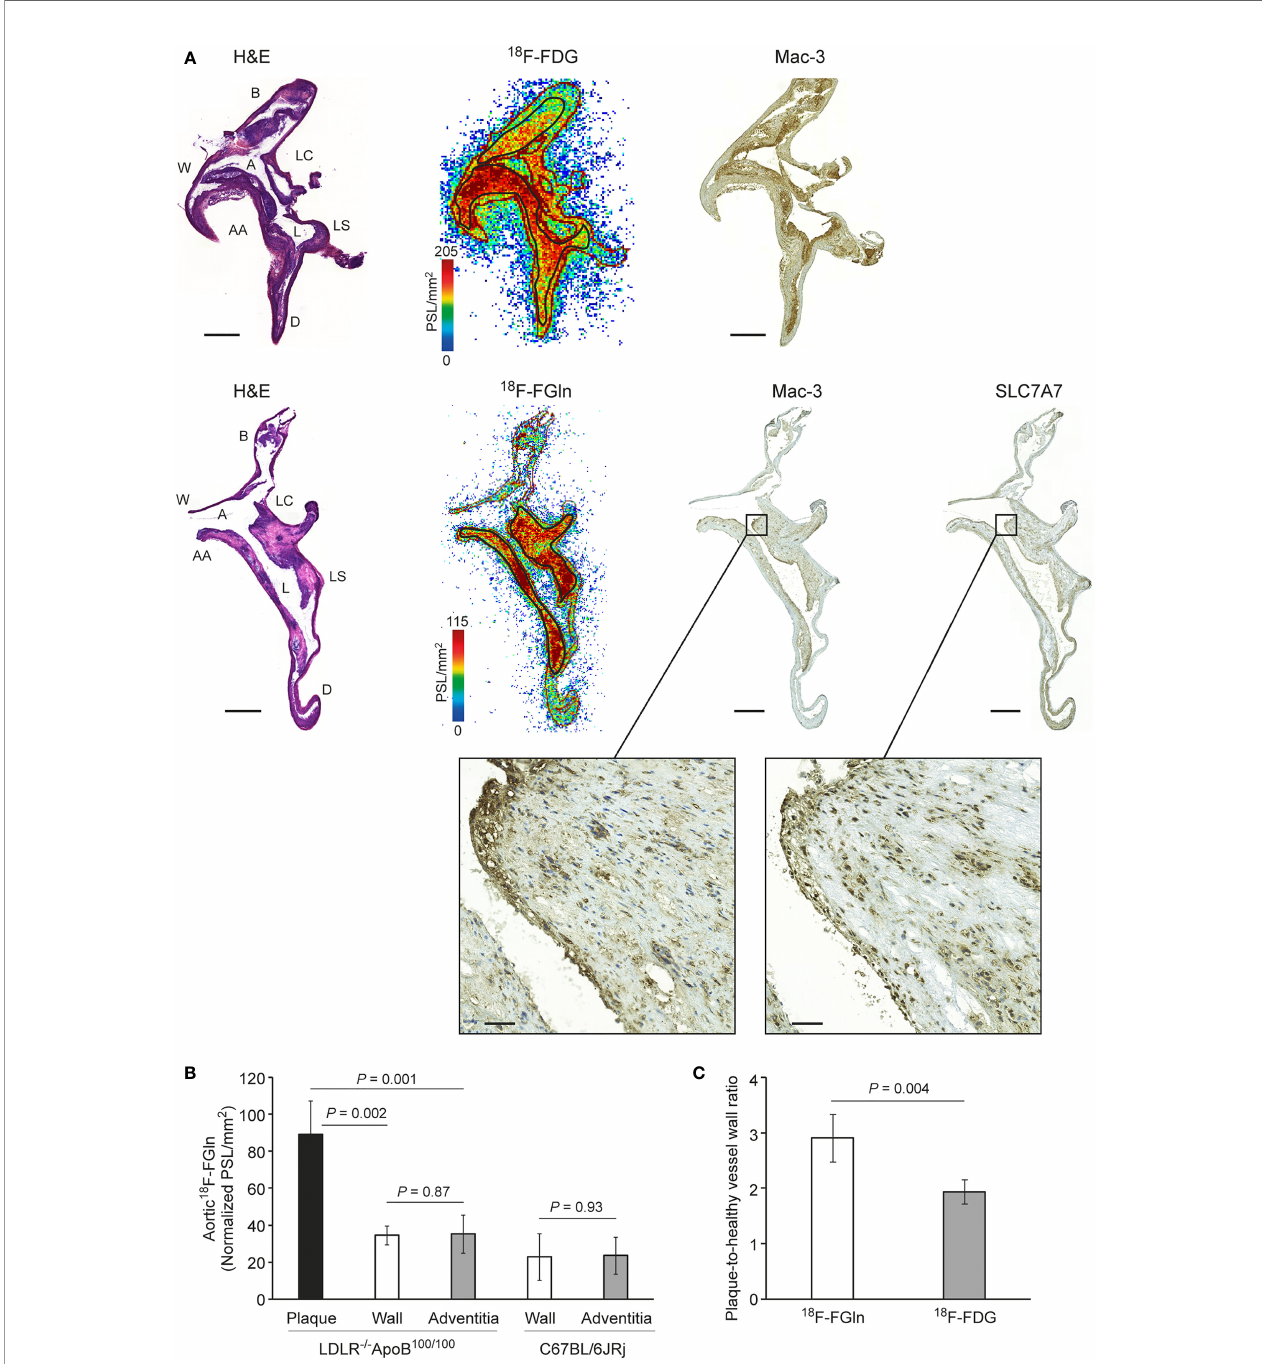
FIGURE 3 | (A) Representative images showing hematoxylin – eosin (H&E) staining, autoradiographs, Mac-3 macrophage staining, and SLC7A7 glutamine transporter staining in consecutive aorta cryosections from atherosclerotic mice. Black rectangles denote the plaque region shown at higher magni fi cation. Scale bar = 500 µm; zoomed region scale bar = 50 µm. A, arch; AA, ascending aorta; B, brachiocephalic artery; D, descending thoracic aorta; L, lesion; LC, left common carotid artery; LS, left subclavian artery; W, vessel wall. (B) Quanti fi cation of 18 F-FGln ex vivo autoradiography data showing differences in tracer uptake between plaques, vessel wall, and adventitia in LDLR -/- ApoB 100/100 atherosclerotic and C67BL/6JRj healthy control mice aortas. Values are expressed as the mean ± SD ( n = 5). (C) Quanti fi cation of autoradiography data showing a signi fi cant difference between the tracers ( n = 5). Values are expressed as the mean ± SD. P -values were calculated using a two-tailed unpaired Student ’ s t